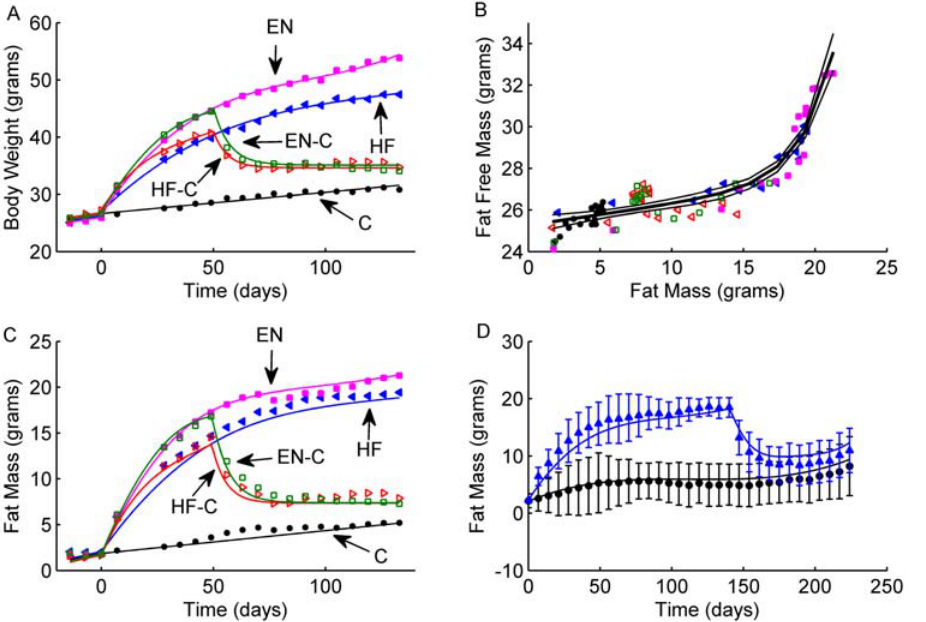
Figure 1. C57BL/6 mouse data and model predictions for fat mass. Panel A: measured body weight in male C57BL/6 mice from 5 diet groups: the C group on chow diet (closed black circles), the HF group on high fat diet (closed blue triangles), the EN group on high fat diet plus Ensure (closed pink squares), the HF-C group on high fat diet for 7 wk followed by a switch to chow (open red triangles), and the EN-C group on high fat diet plus Ensure for 7 wk followed by a switch to chow (open green squares). The solid lines labeled are fitted curves to body weight data. Panel B: Measured body fat mass (F) and adjusted fat free mass (FFM) from the 5 groups designated using the same markers as in Panel A. These data were fit to a single exponential function for all groups: FFM ~ 25 : 3 z 0 : 10 | F z 0 : 00042 | exp 0 : 45 | F f g (thick line with thin lines representing 95% confidence intervals). Panel C: measured fat mass from the 5 groups where the data point markers was the same as in Panel A. The solid lines are model predictions for fat mass. Panel D: measured fat mass from a separate experiment with two groups of male C57BL/6 mice: group one on chow diet for 33 wk (closed black circles); group two on high fat diet for 20 wk followed by a switch to chow (closed blue triangles). The error bars represent 95% confidence interval for the measurements. The curves represent the model predictions for fat mass in groups one (black) and two